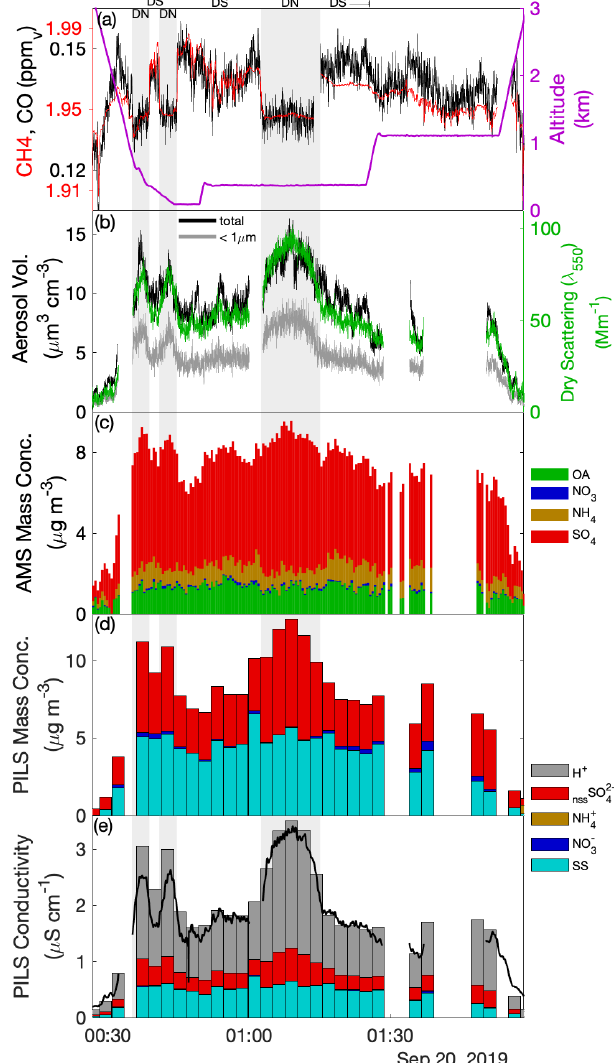
Figure 3. Time series of aerosol and trace gases during low-level sampling downwind of the cloud wall during Case I. (a) Gas tracers CO and CH 4 and aircraft altitude, (b) bulk aerosol dry scattering at 550nm and integrated aerosol volume from the LAS for all size and sub-micrometer size bins, (c) AMS-speciated (sub-micrometer) mass concentrations, (d) PILS bulk mass concentrations for ma- jor ion groups and (e) PILS bulk conductivity and closure analysis of major ion contributions. H + ion contributions show the H + re- quired for charge neutrality. Grey-shaded background regions high- light periods of special interest (see